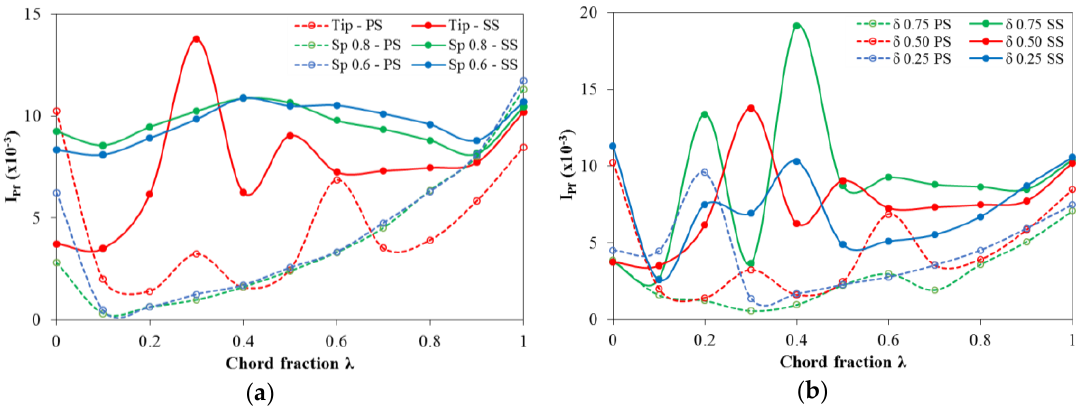
Figure 12. Pressure fluctuation intensity on blade. ( a ) I pf for three spans ( δ = 0.5%); ( b ) I pf at tip edge for three tip-clearance size (TCS) cases.